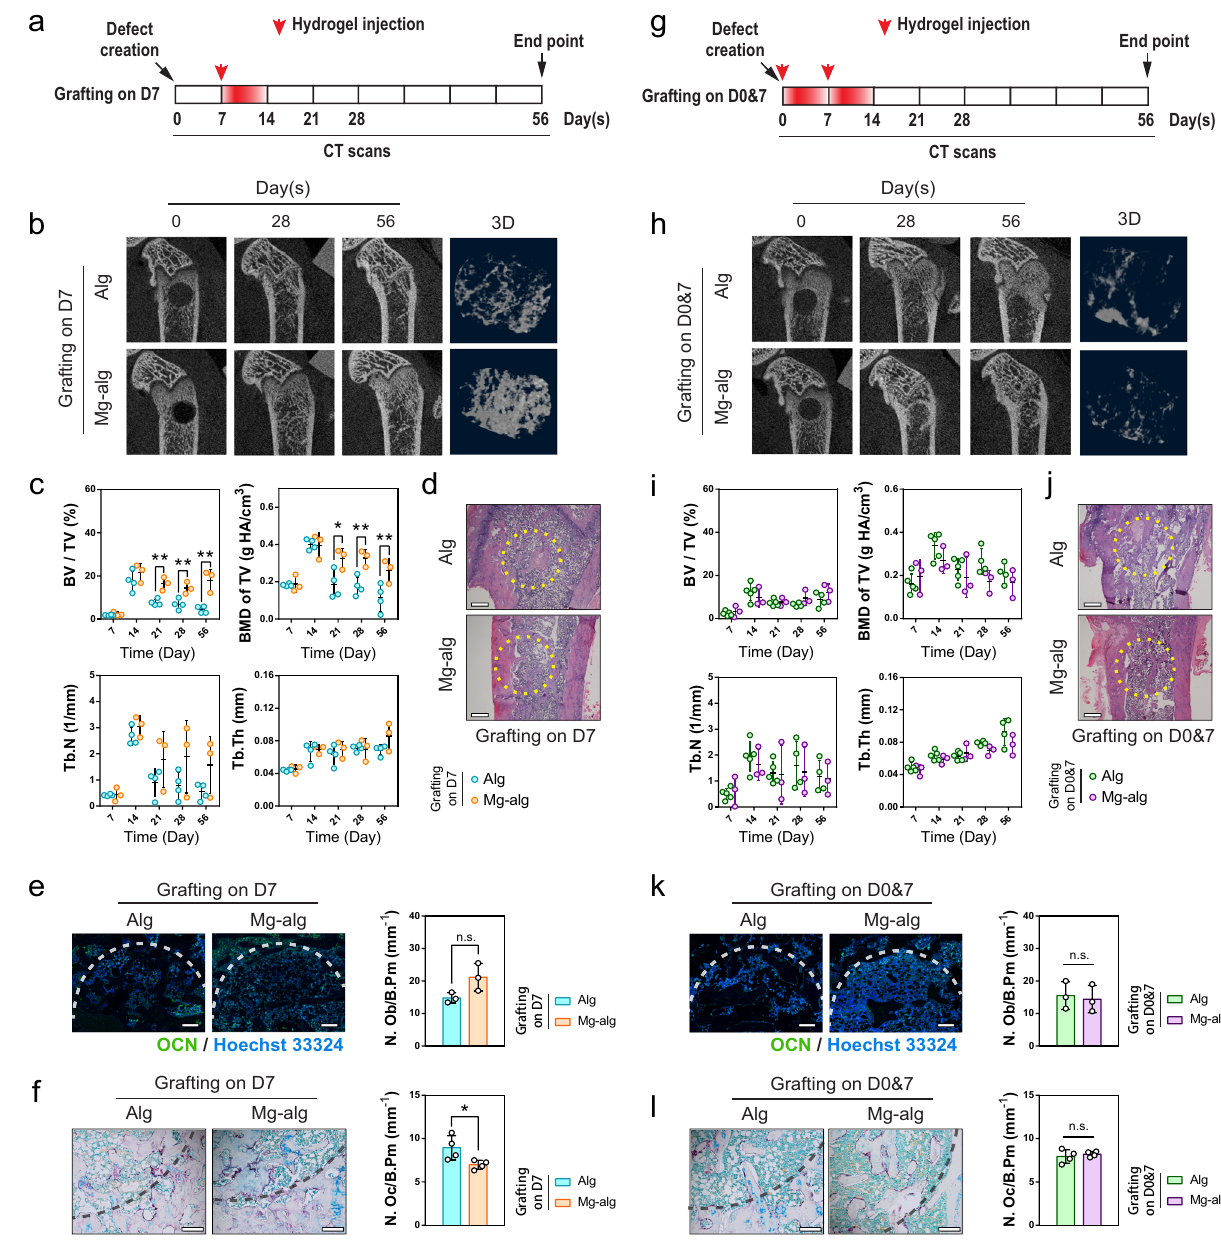
Fig. 2 Delayed or prolonged delivery of Mg 2 + compromised its effects on bone healing. a Mg 2 + -crosslinked alginate was injected into the femur defect on the seventh day after the injury to exclude the effects of Mg 2 + on early phrase in fl ammation. b Representative micro-CT and reconstructed 3D images of the defects in rat femur on day 56 when the grafting was delayed. c Corresponding measurements of BV/TV, Tb.N, BMD of TV, and Tb.Th showing the healing process of rat femoral defects. Alg, n = 4; Mg-alg, n = 3. d Representative H&E staining images of the grafted defects in the rat femora, scale bars = 500 µ m. e Representative immuno fl uorescent images and quanti fi cation showing the presence of osteoblast in the grafted defects in the rat femora on day 56, scale bars = 500 µ m. f Representative TRAP staining images and quanti fi cation showing the presence of osteoclasts in the grafted defects in the rat femora on day 56 ( n = 4), scale bars = 200 µ m. g Mg-crosslinked alginate was injected into the femur defect in rats at both the fi rst and seventh days after the injury to allow sustained release of Mg 2 + in the fi rst two weeks of injury. h Representative micro-CT and reconstructed 3D images of the defects in rat femur on day 56 when the grafting was repeated ( n = 4). i Corresponding measurements of BV/TV, Tb.N, BMD of TV and Tb.Th showing the healing process of rat femoral. Alg, n = 4; Mg- alg, n = 3. Data are mean±s.d. j Representative H&E staining images of the grafted defects in the rat femora on day 56, scale bars = 500 µ m. k Representative immuno fl uorescent images and quanti fi cation showing the presence of osteoblast in the grafted defects in the rat femora on day 56 ( n = 4), scale bars = 500 µ m. l Representative TRAP staining images showing the presence of osteoclasts in the grafted defects in the rat femora on day 56 ( n = 4), scale bars = 200 µ m. Data are mean±s.d. n.s. P >0.05, * P <0.05, ** P <0.01 by two-way ANOVA with Tukey ’ s post hoc test ( c , i ) or Student ’ s T -test ( e , f , k , l TRAP + osteoclastic-like cells at the early stage (i.e., day 7) of represented macrophages as the Mg 2 + -dependent recruitment of CD68 + cells vanished in animals treated with intraperitoneal bone healing (Fig. 3c). They are closely related to the group of administrations of liposome-encapsulated clodronate 39 (Fig. 3a, b). macrophages responding to the stimulation of Mg 2 + because these Meanwhile, the addition of Mg 2 + also contributed to a group of CD68 + osteoclastic-like cells (Fig. S4d) were also missing in the